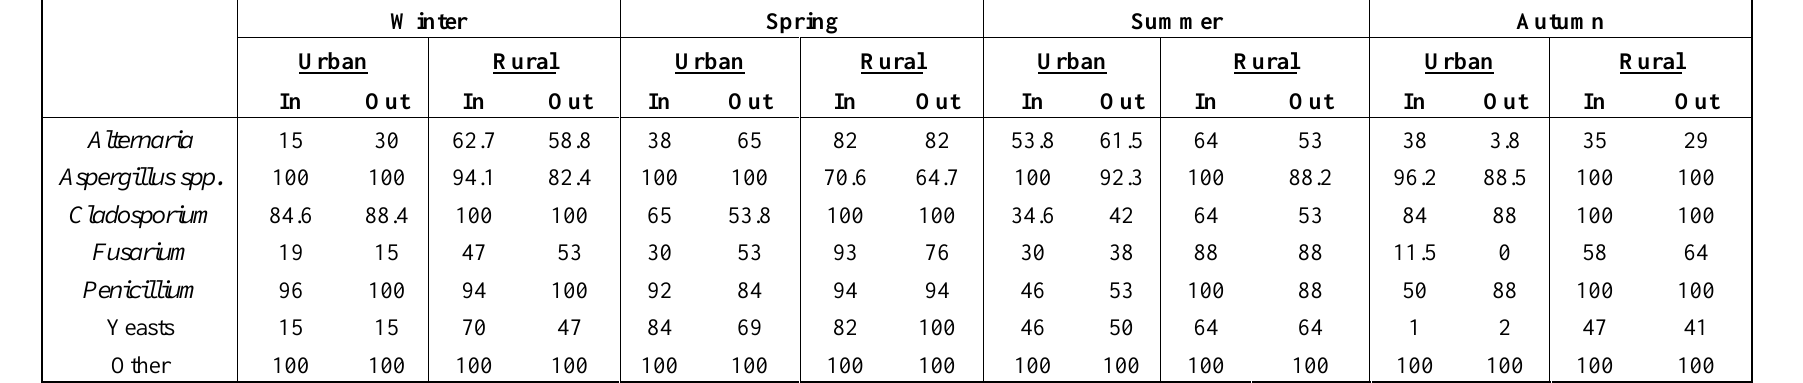
Table 6. Frequency of occurrence (n = 26-urban, n = 17-rural) as percent of homes positive for most prevalent fungal organisms for the indoor (In) and outdoor (Out) by season. Winter Spring Summer Autumn Urban Rural Urban Rural Urban Rural